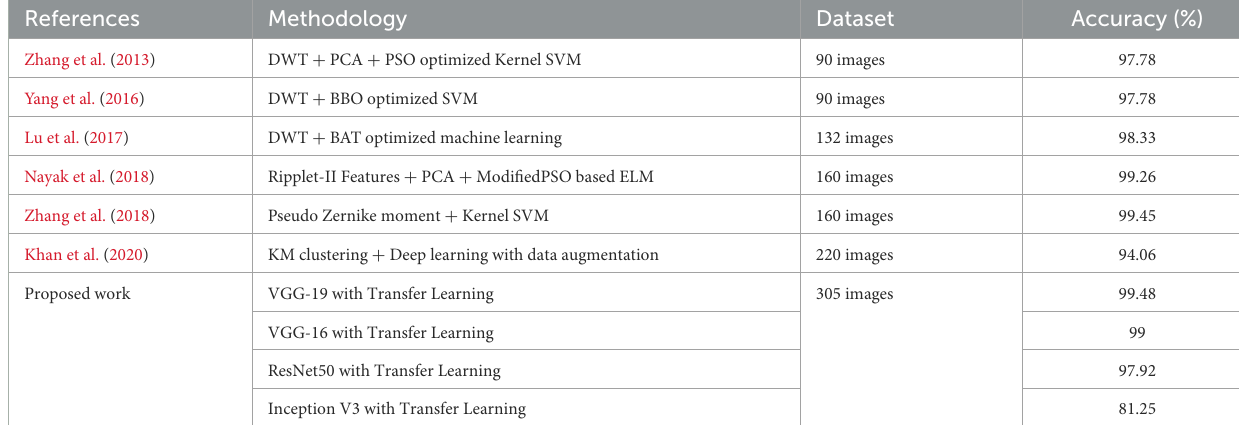
TABLE 3 Comparison of the pre-trained models using transfer learning technique with existing state-of-the-art